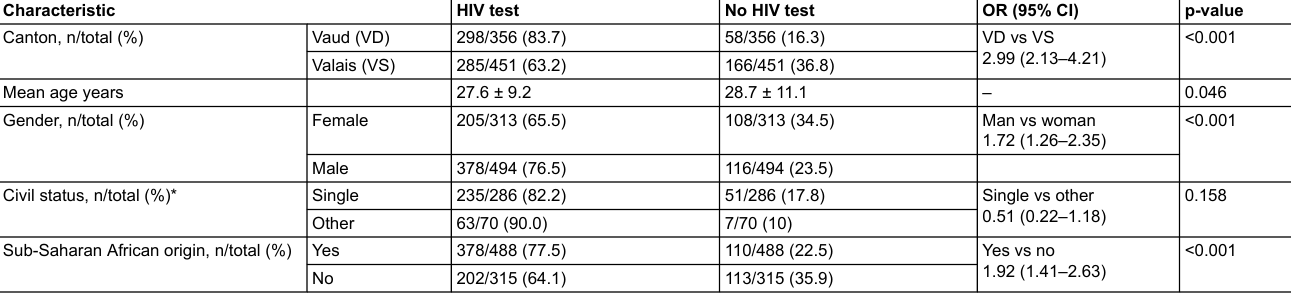
*Totals for each characteristic may differ because of missing values Table 2: Univariate analysis of factors associated with the acceptance of HIV screening. Characteristic